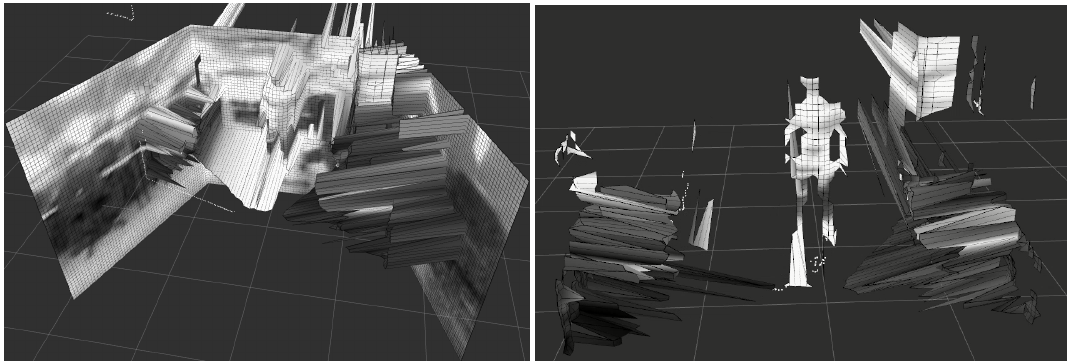
Figure 13. Impact of the ’grid baseline’ parameter.